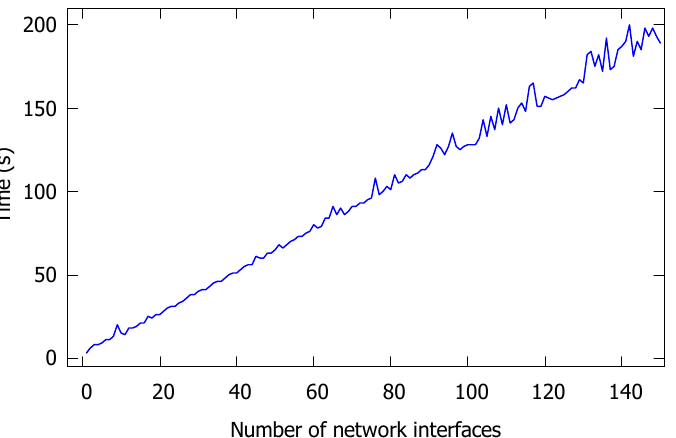
Figure 7. Startup times (in seconds) of a VD with a given number of network